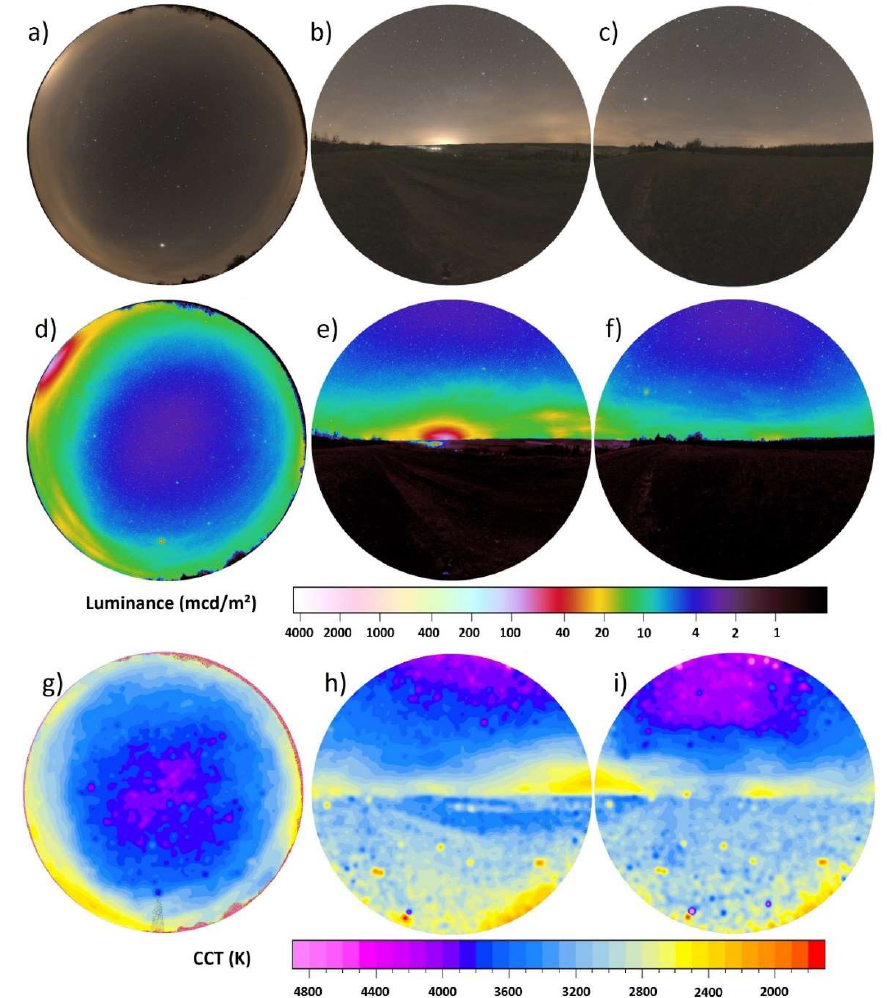
Figure 5. Clear night imaging data Zselic, Hungary. ( a – c ) RGB, ( d – f ) luminance, ( g – i ) correlated color temperature (CCT). Left column ( a , d , g ) all-sky data, middle ( b , e , h ) and right ( c , f , i ) columns vertical plane data.